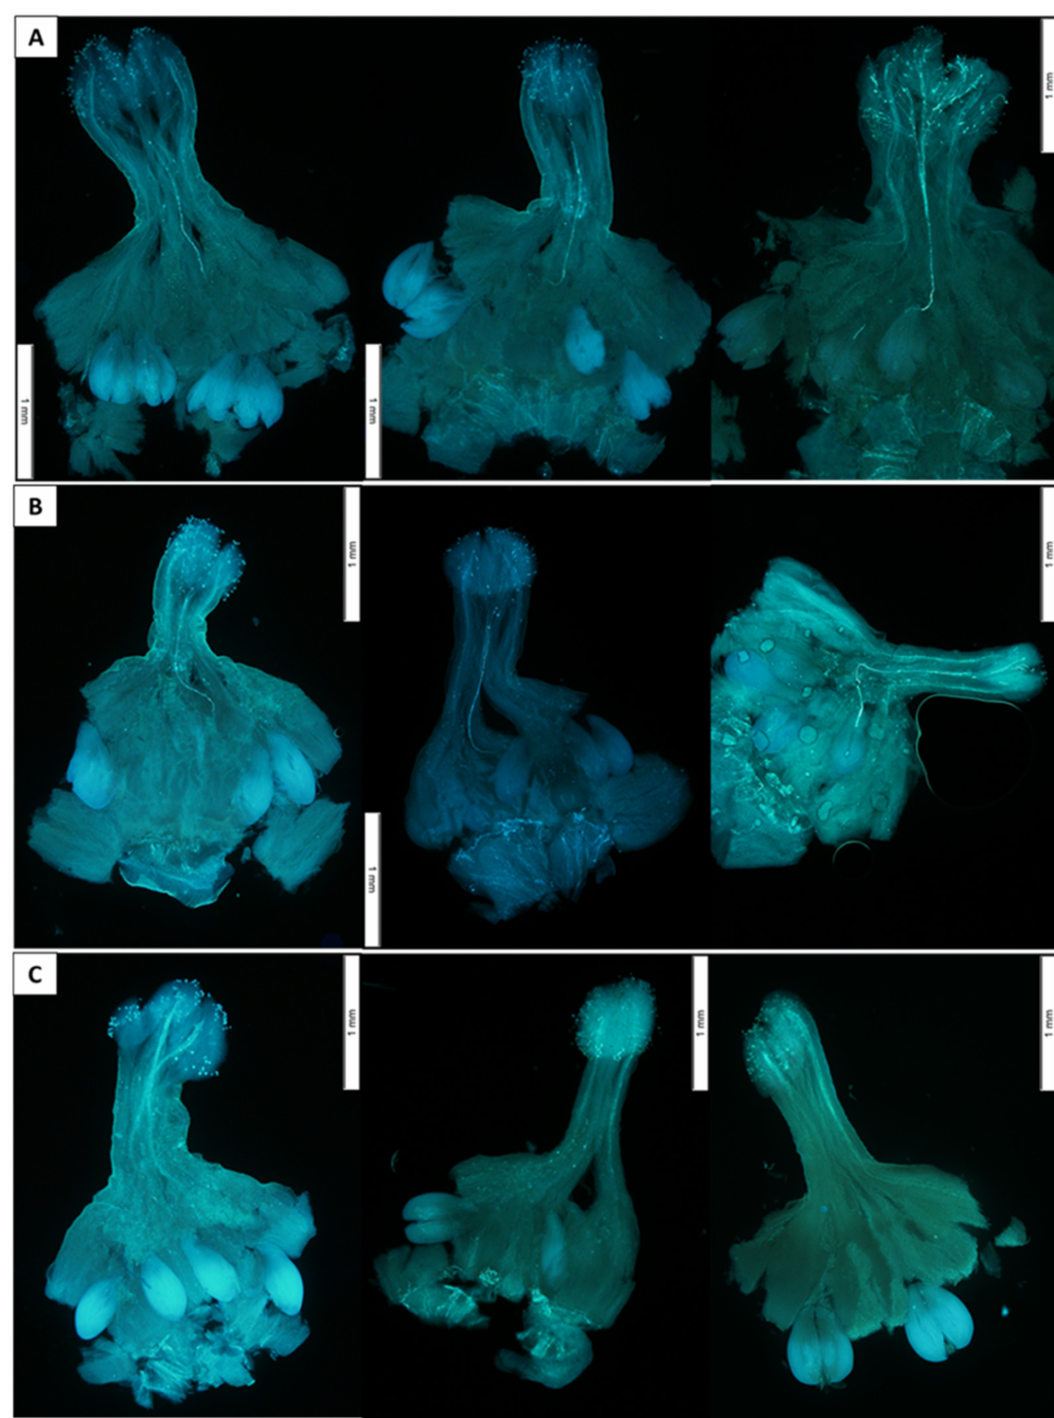
Figure 4. Stained pistils showing pollen tube growth from ( A ) intraspecific, ( B ) interspecific, and ( C ) self crosses of Osmanthus armatus 24 h (left), 48 h (middle), and 72 h (right) post-pollination. Crosses shown from top to bottom are: O. armatus ‘Jim Porter’ × O. armatus ‘Longwood’, O. armatus ‘Jim Porter’ × O. heterophyllus ‘Kaori Hime’, and O. armatus ‘Jim Porter’. Pistils were fixed, rinsed, hydrolyzed, stained with decolorized aniline blue, and placed on microscope slides. Slides were observed after 1 h using an Olympus BX-60 compound microscope with an Olympus Q Color 5 digital camera for image